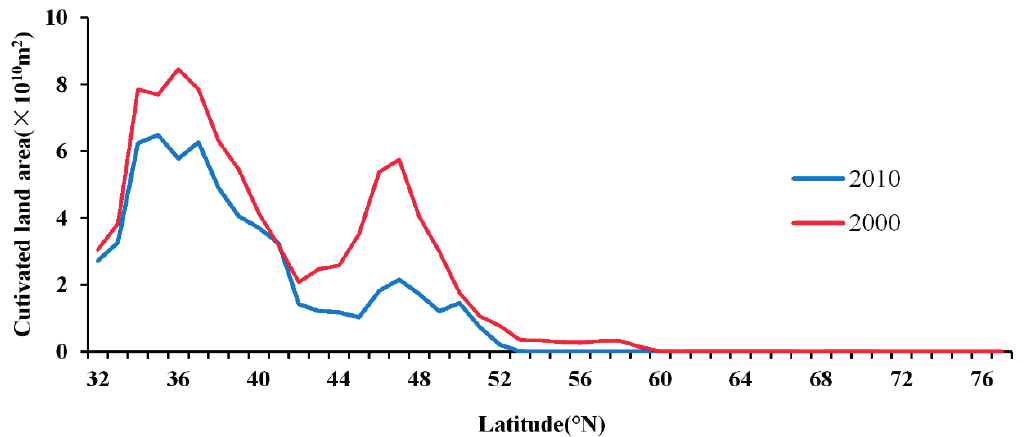
Figure 8. The latitudinal graded distribution of the cultivated land in 2000 and